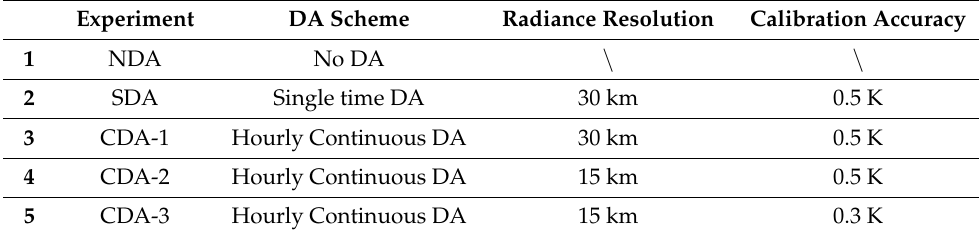
Figure 7. Observing system simulation experiment framework. R denotes the observation error covariance; B denotes the background error covariance. Table 2. Details description of five